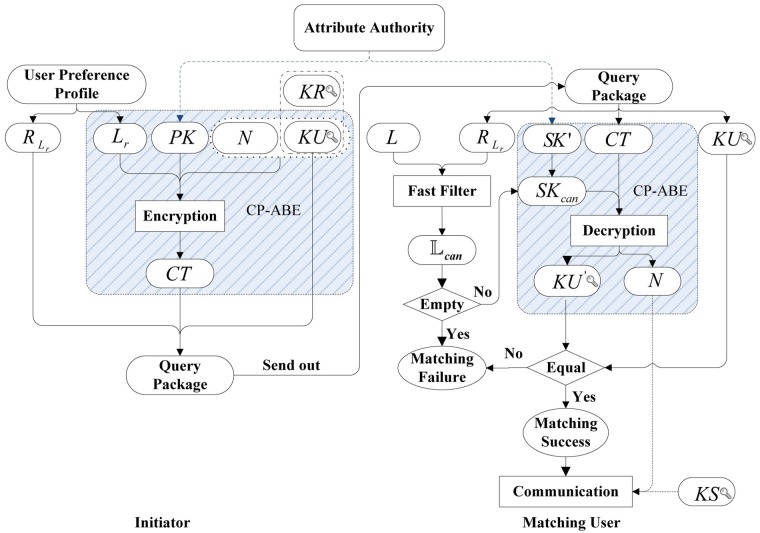
Main process of our scheme.